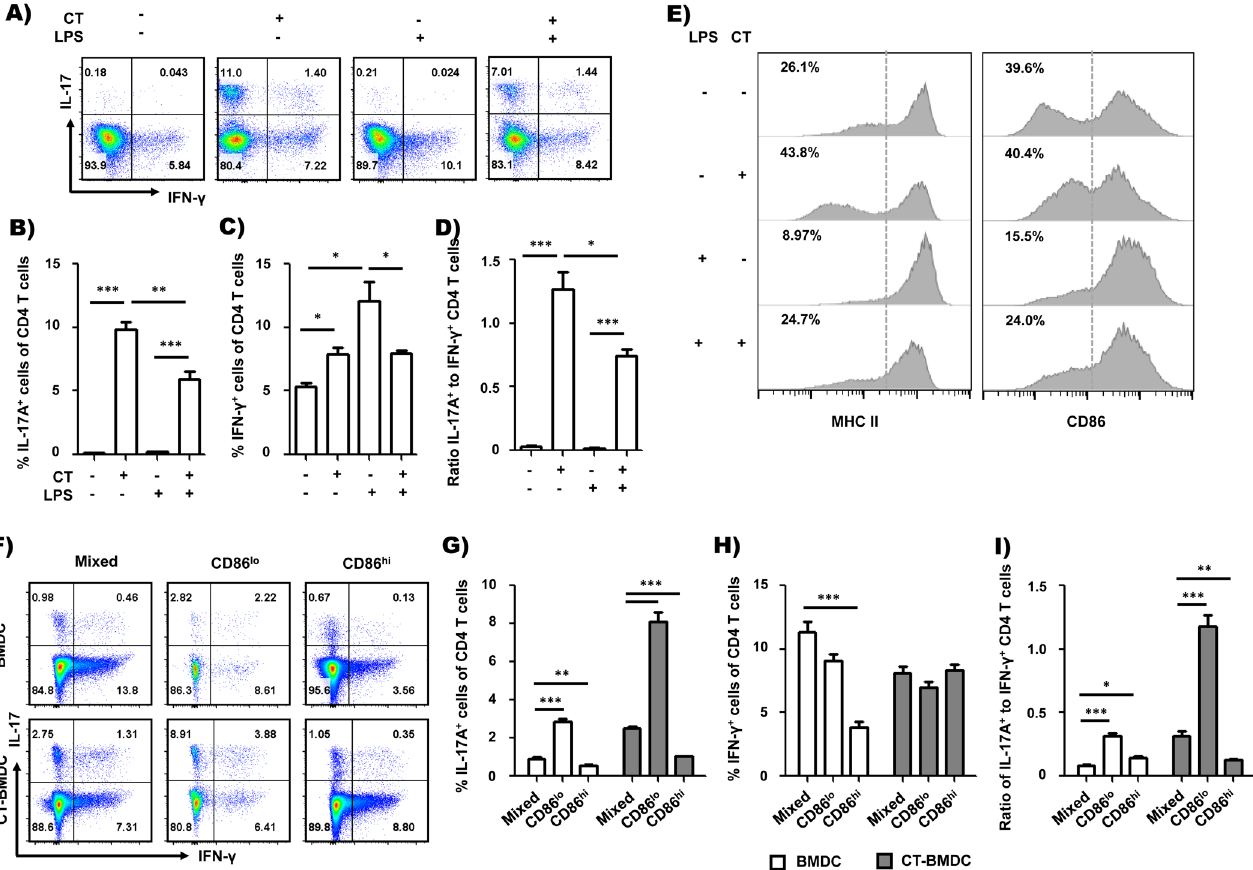
with CT (2 μ g/ml), LPS (100 ng/ml) or CT and LPS or not treated for 24 hr. (F-I) Comparison of OT-II CD4 + T cell differentiation by isolated BMDCs or CT-treated BMDCs based on MHC class II and CD86 expression. Frequency of IFN- γ - or IL-17A-expressing CD4 + T cells (F-H) and ratio of